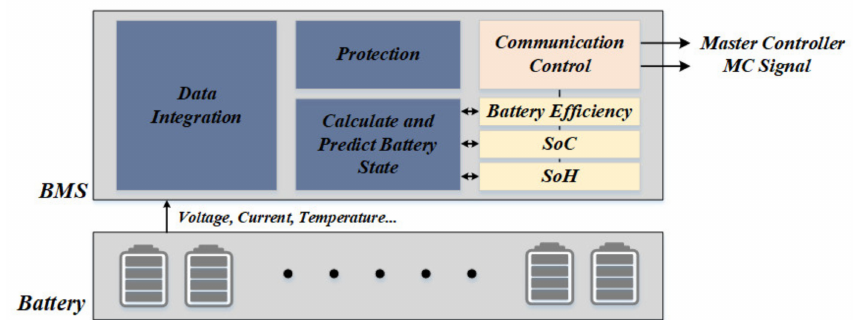
Figure 3. Proposed BMS configuration diagram.